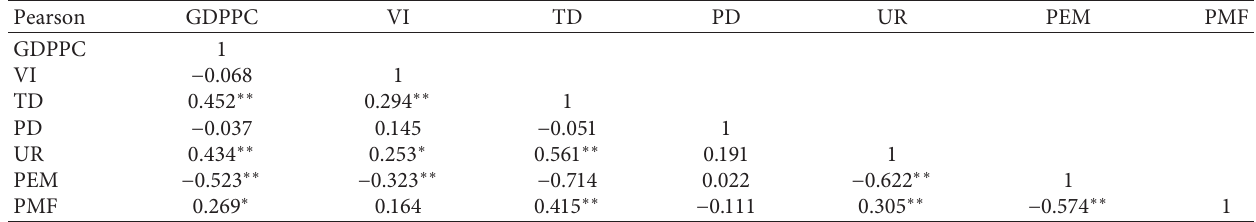
Table 4: The correlation coefficient between regional development factors in Xinjiang.